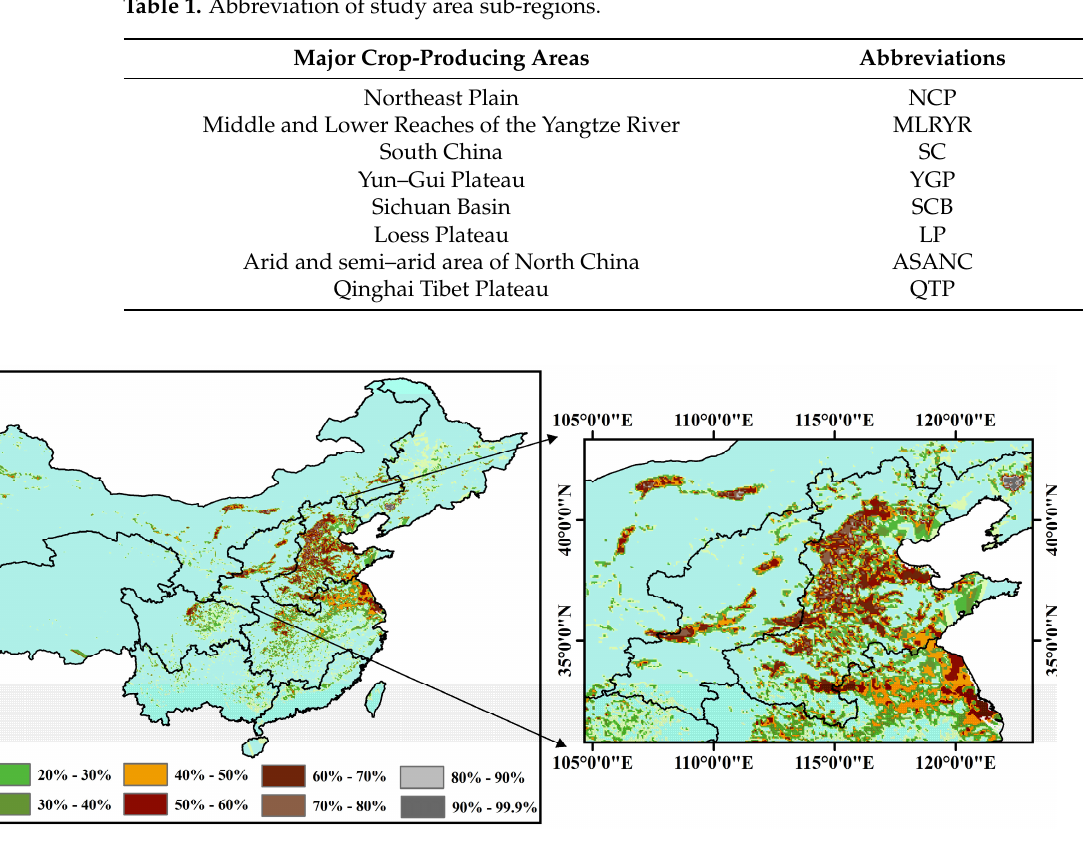
Figure 2. Spatial distribution of irrigation degree in China. The percentage of irrigation degree showed the proportion of irrigation water to the total water demand of crops in the growth period.